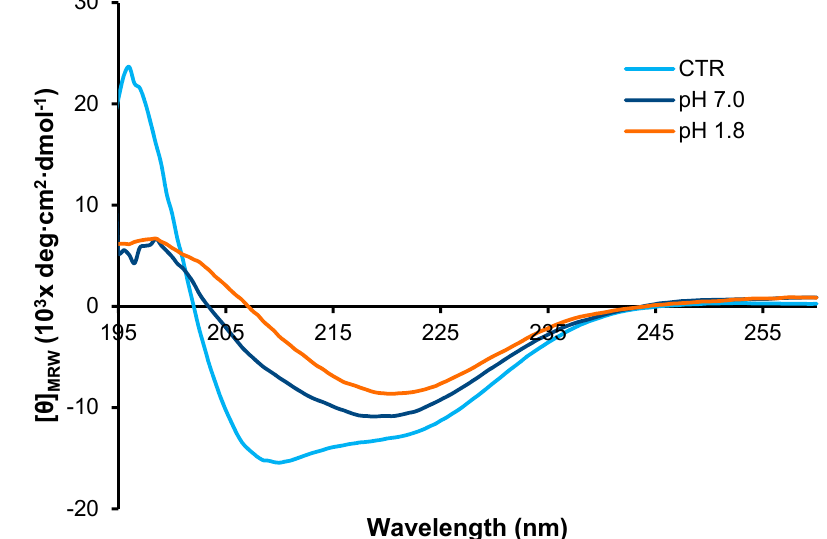
Figure 4. CD analysis of insulin fibrils. Far-UV CD spectra of human insulin after 24 h of incubation in aggregating conditions at pH 7.0 and pH 1.8. CTR refers to the protein in native conditions. Experimental details are described in the Materials and Methods section.